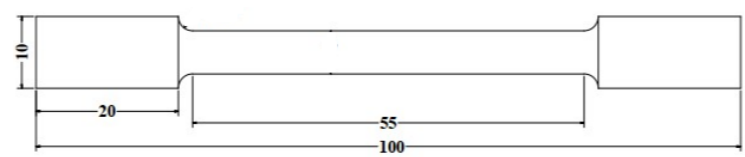
Figure 2: Sample for the tensile test.